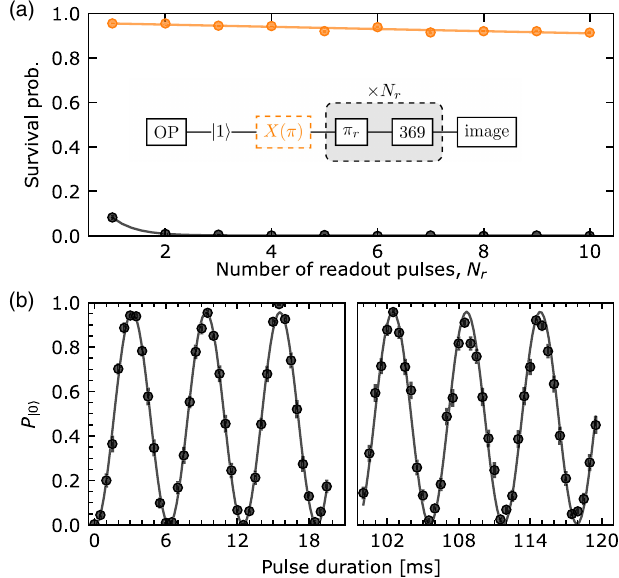
FIG. 2. (a) Atom survival probability after N repetitions of the r blowout sequence through the Rydberg state, after preparing an atom in j 1 i (black) and j 0 i (orange). (b) Rabi oscillations of the 2 π × 161 . 7 ð 5 Þ Hz. The error bars nuclear spin qubit, with Ω rf ¼ indicate the statistical uncertainty ( (cid:3) 1 σ ) in the measured survival